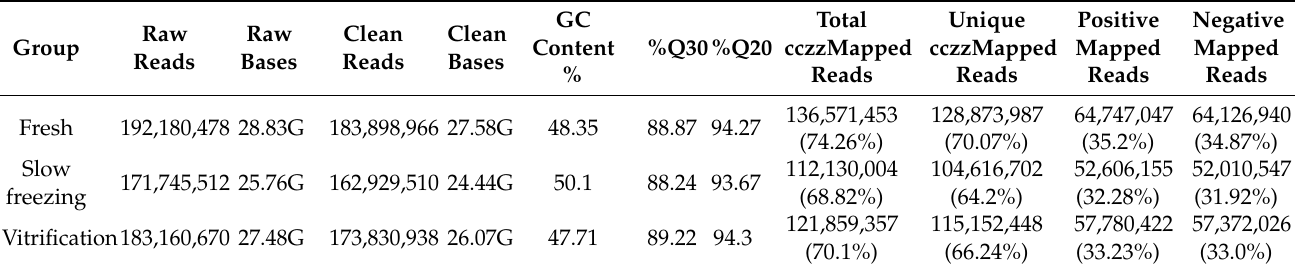
Table 1. Overview of transcriptome sequencing in fresh and frozen–warmed human spermatozoa.